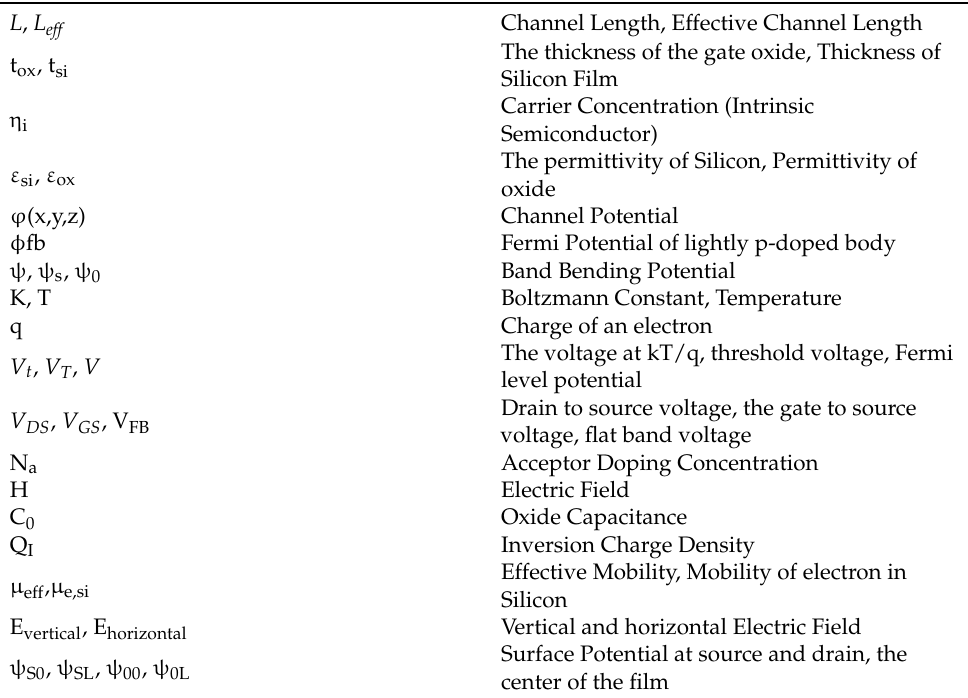
Table A1. List of parameters used in